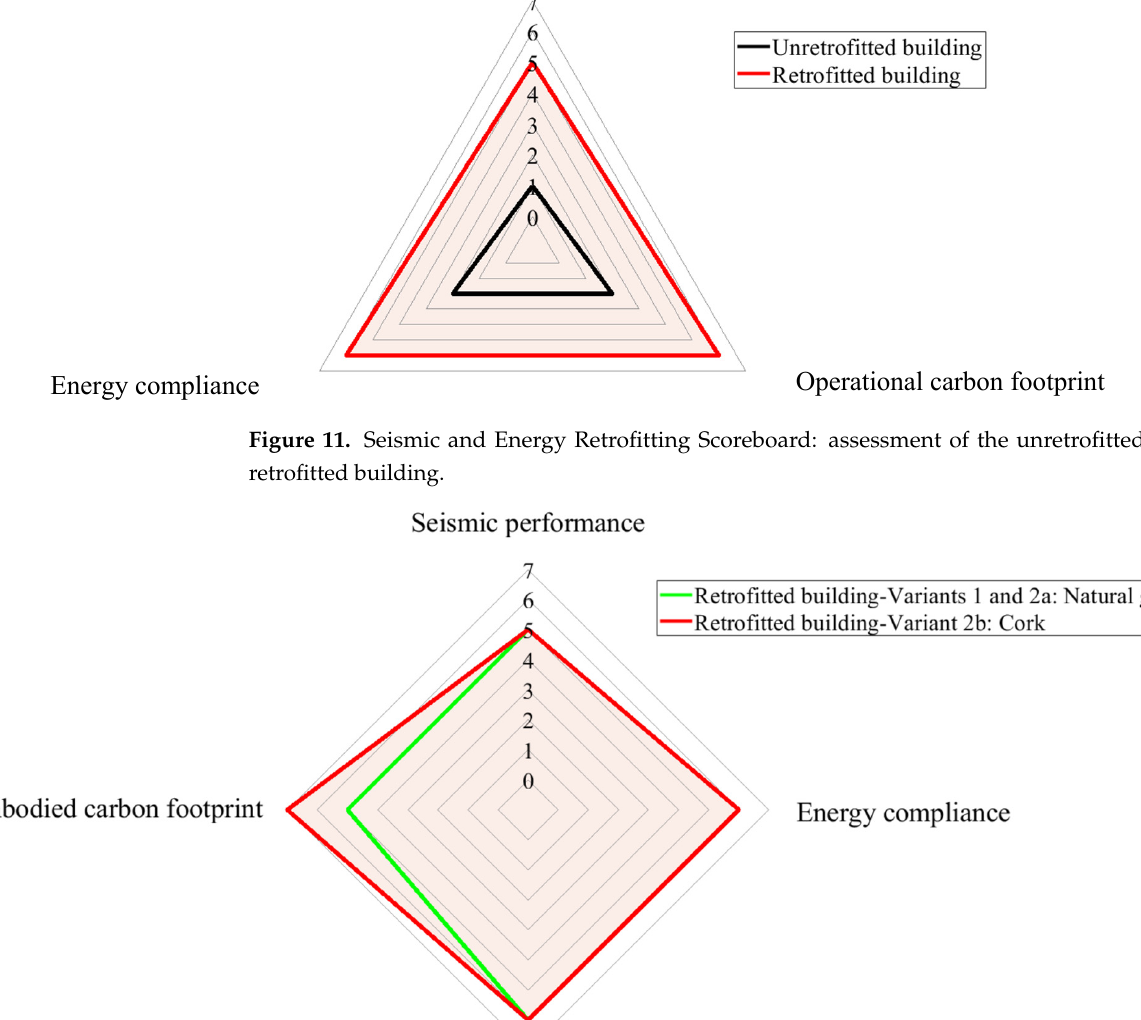
Figure 12. Seismic and Energy Retrofitting Scoreboard: assessment of the different retrofitting strat-